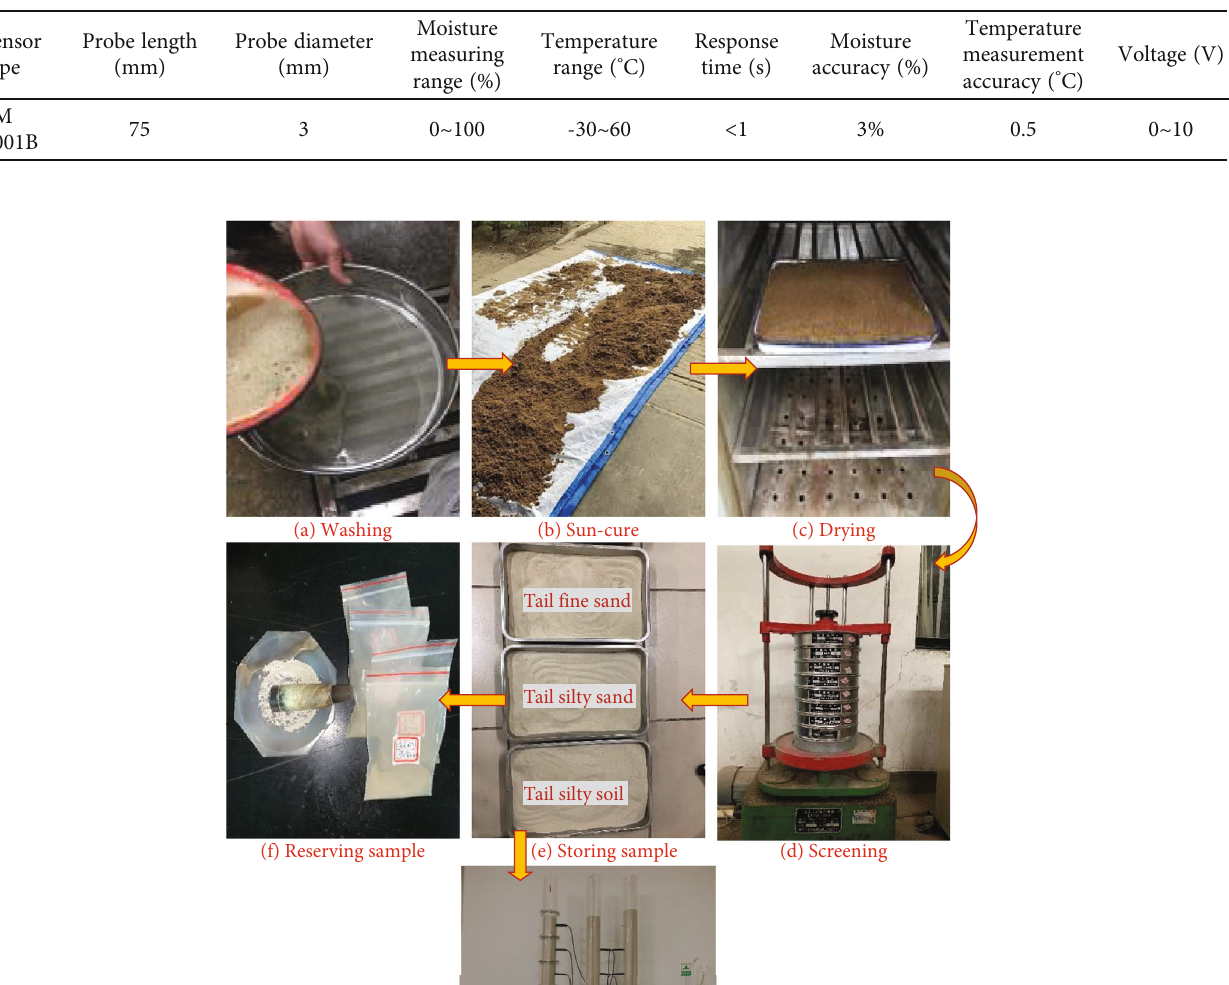
Table 2: Main technical indexes of SM3001B.